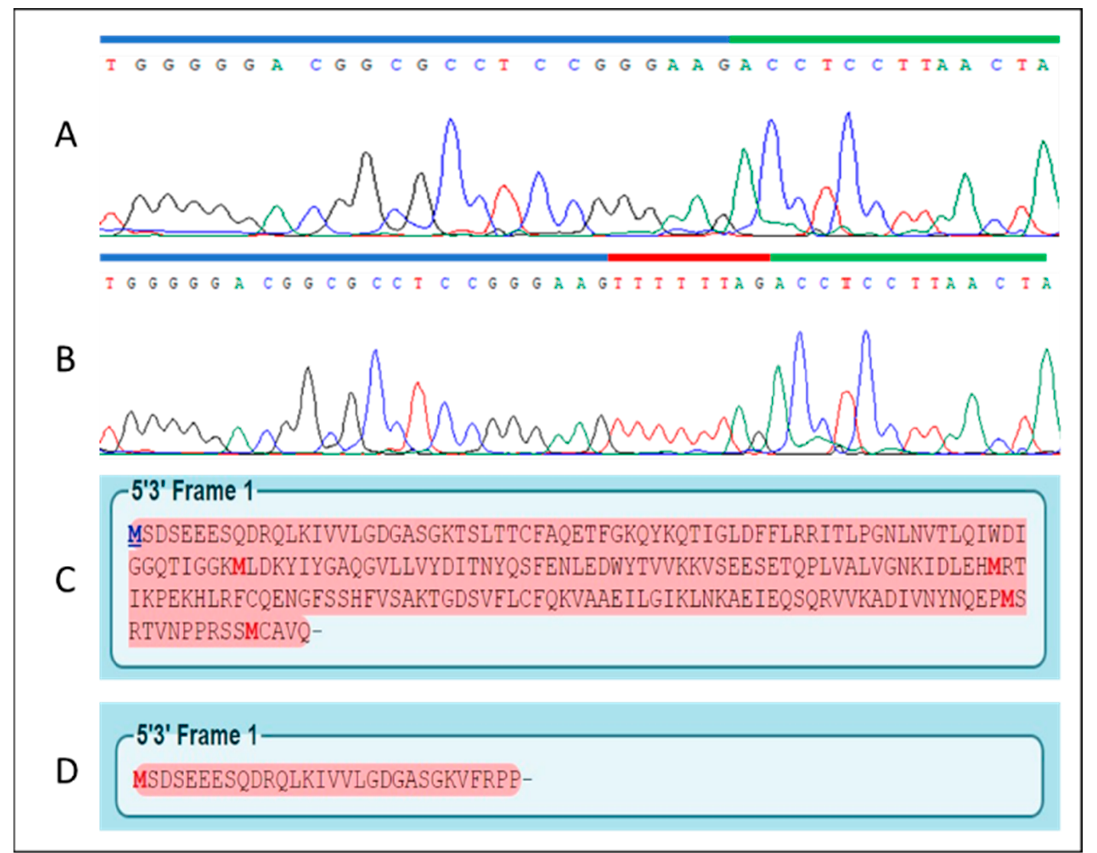
Figure 2. Sequence chromatograms of the wild-type mRNA ( A ) and the c.76-9A > G variant ( B ). The blue bar represents a portion of Exon 1, the green bar a portion of Exon 2, the red bar shows the retention of a 8nt sequence caused by the splicing variant in intron 1. Below, the wild-type amino acid sequence ( C ) and the predicted shorter sequence translated from the mutant mRNA ( D ). Pink shading represents the open reading frame, bold red letters identify Methionine residues or start codons.